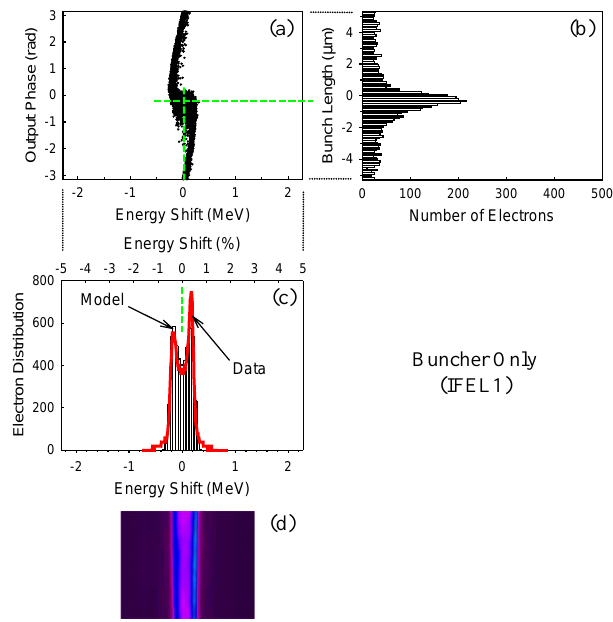
FIG. 2. (Color) Comparison of buncher only results with model. (a) Model-predicted electron output phase versus electron en- ergy, (b) model-predicted electron bunch length, (c) electron en- ergy spectrum, and (d) raw spectrometer output for data plotted in